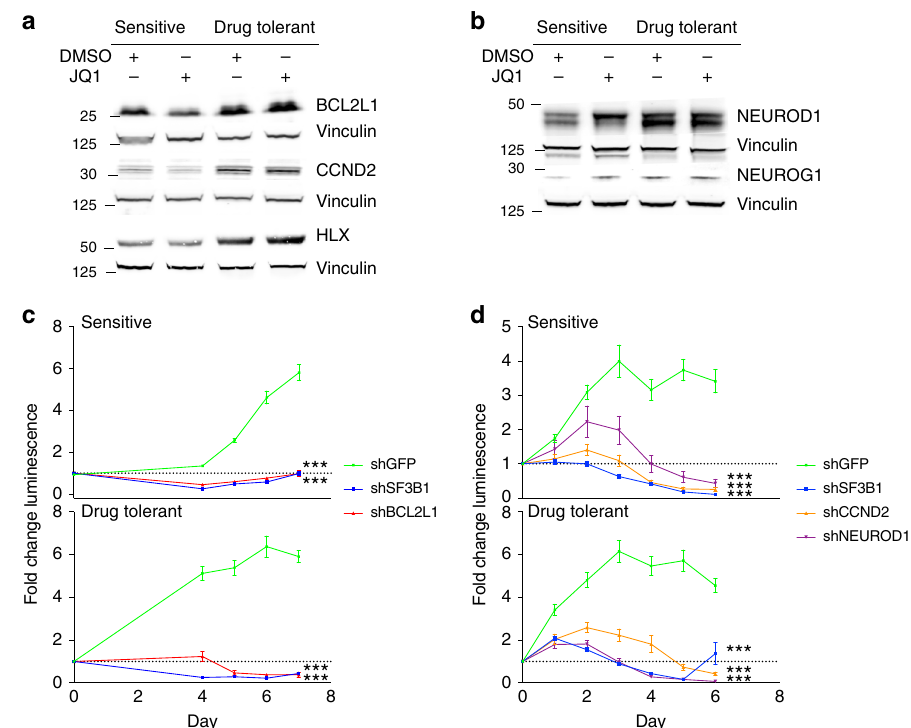
Fig. 5 Drug tolerant cells express BETi mediator and rescue genes a Immunoblots probing for BETi-mediator proteins BCL2L1, CCND2, HLX in D458 sensitive and drug-tolerant cells following 24 h of treatment with JQ1 (1 μ M) or vehicle control. Vinculin is included as a loading control. Source data: Source Data File. b Immunoblots probing for BETi-rescue proteins NEUROD1 and NEUROG1 in D458 sensitive and drug-tolerant cells following 24 h of treatment with JQ1 (1 μ M) or vehicle control. Vinculin is included as a loading control. Source data: Source Data File. c Fold change in proliferation (as measured by luminescence) of D458 sensitive cells (top panel) and D458 drug tolerant medulloblastoma cells (bottom panel) following lentiviral infection with short hairpins targeting eGFP (negative control), SF3B1 (positive control) and BCL2L1. Values represent mean of 15 independent measurements across three replicate experiments ± SEM. Asterisks (***) denotes p values of <0.0001 as determined by two-tailed unpaired T -tests. Source data: Source Data File. d Fold change in proliferation (as measured by luminescence) of D458 sensitive cells (top panel) and D458 drug tolerant medulloblastoma cells (bottom panel) following lentiviral infection with short hairpins targeting eGFP (negative control), SF3B1 (positive control), CCND2 and NEUROD1. Values represent mean of 15 independent measurements across three replicate experiments ± SEM. Asterisks (***) denotes p values of < 0.0001 as determined by two-tailed unpaired t -tests. Source data: Source Data